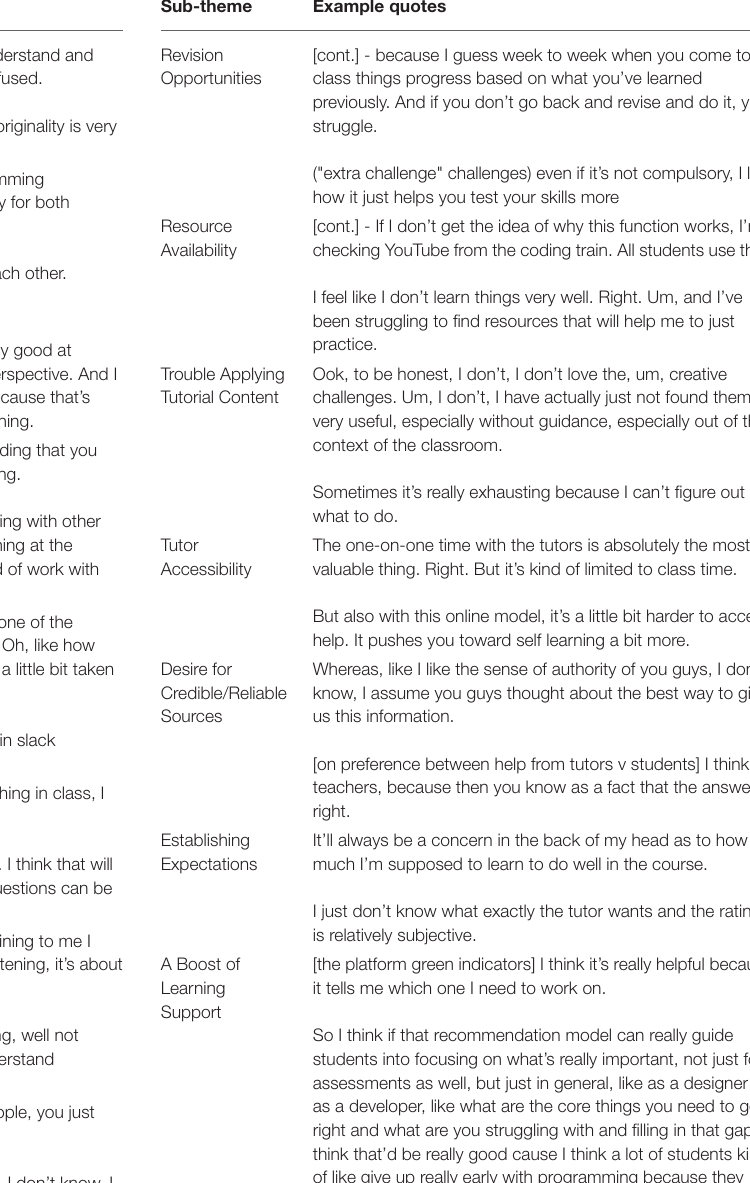
TABLE 4 | Sub-themes within the “Social Learning” theme. TABLE 5 | Sub-themes within the “Learning Support”